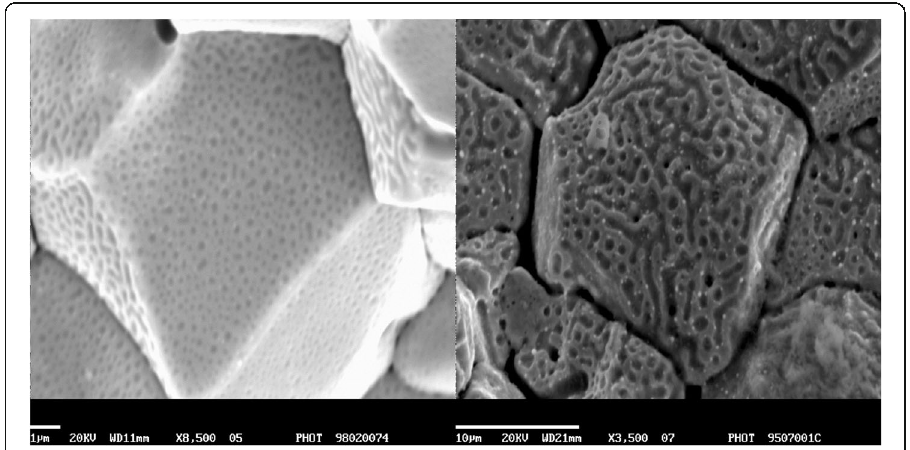
Fig. 13 Example scanning electron microscope images of grain boundary porosity of irradiated nuclear fuels during early stages of formation ( left ) and advanced stages (White 2004; White et al.